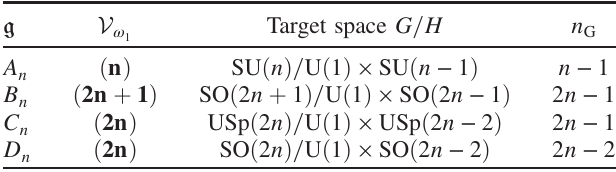
TABLE I. Target spaces associated with classical continuous ferromagnets, describing the low-energy sector of quantum ferromagnetic chains with local degrees of freedom realized in the defining representation V ω of a Lie algebras g . Here, n is the G 1 number of Goldstone modes in the spectrum.